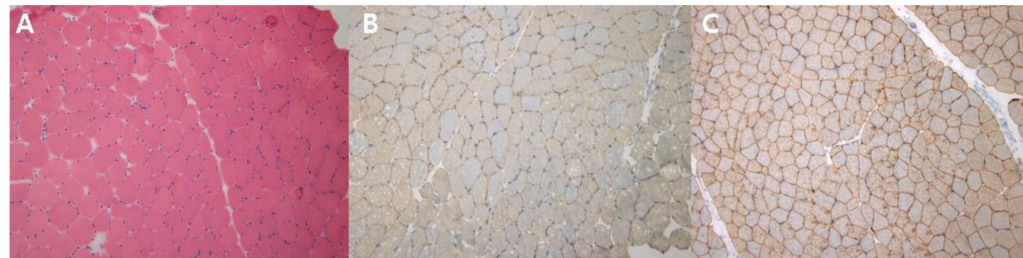
Figure 4. The results of muscle biopsy. ( A ) Mild inflammatory cell infiltration on H&E stain ( × 100). ( B ) Under-expression of dysferlin, as demonstrated by immunohistochemistry ( × 100). ( C ) Normal expression of dysferlin (reference) ( × 100).